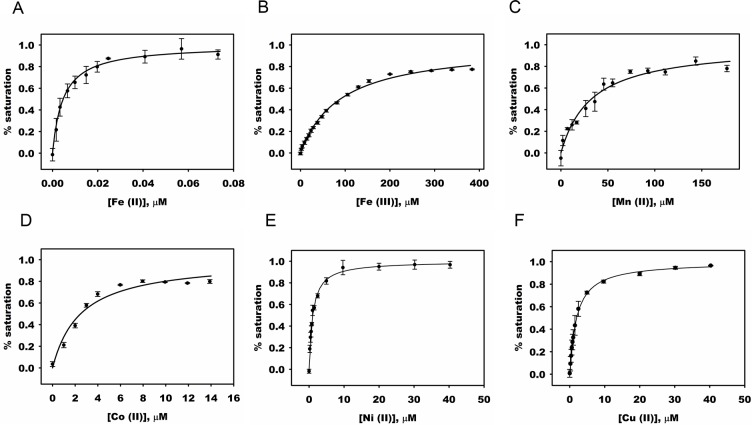
Metal binding affinities (Kd) of DddW.Titration of apo-DddW with increasing concentrations of the metal ions Fe(NH4)2(SO4)2 (added anaerobically), FeCl3, CoCl2, MnCl2, CuCl2 or NiCl2 was done. The binding was monitored by saturation of the fluorescence intensities. The concentration of enzyme used is as follows: (A) 0.5 μM apo-DddW, (B)-(F) 2 μM apo-DddW. The Kd values were: (A) Fe(II), 4.7 ± 0.0 nM; (B) Fe(III), 89.3 ± 4.3 μM; (C) Mn(II), 32.7 ± 5.0 μM; (D) Co(II), 2.5 ± 0.4 μM; (E) Ni(II), 1.0 ± 0.1 μM; (F) Cu(II), 1.9 ± 0.2 μM.